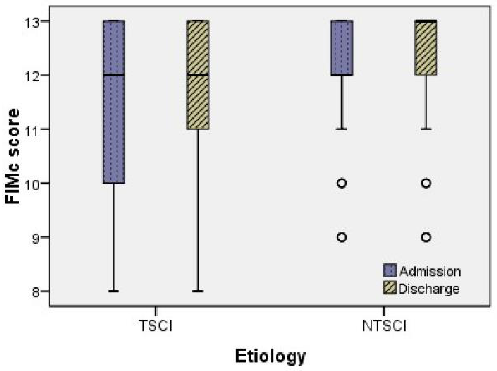
Figure 4. The distribution of FIMm scores cross categories of etiology (T-SCI/NT-SCI).